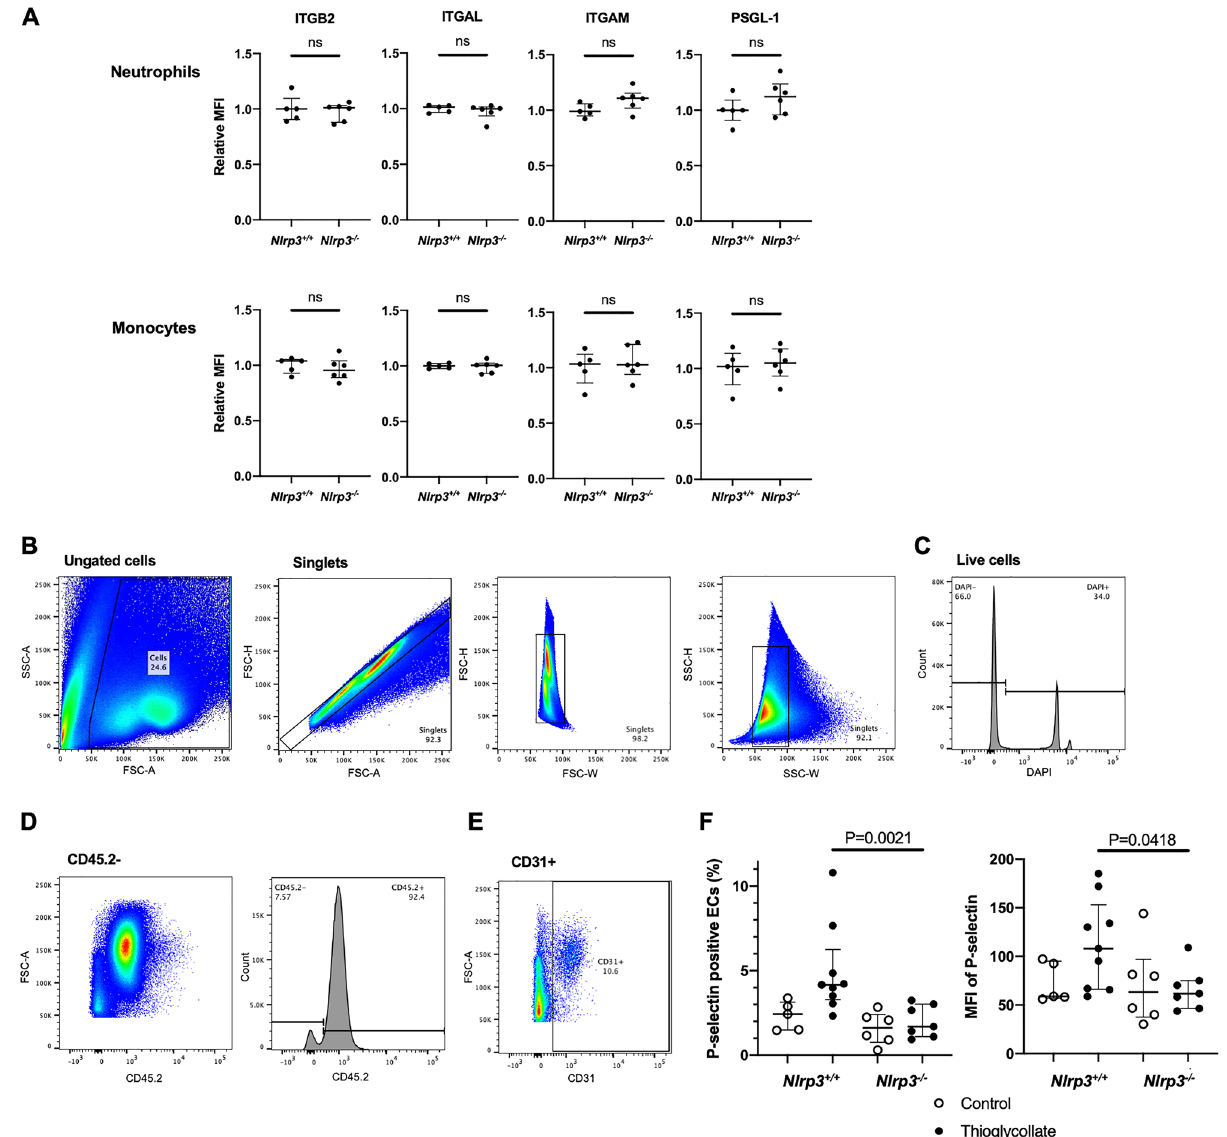
Figure 4. Nlrp3 deficiency reduces membrane expression of P-selectin on the inflamed endothelial cells, while circulating leukocyte adhesion receptors expression is not altered. Neutrophils and monocytes in peripheral blood were collected from Nlrp3 + / + and Nlrp3 −/− mice 4 h after injection of thioglycollate broth (n = 5:6). ( A ) Surface expressions of integrins; integrin β2 (ITGB2, CD18), integrin αL (ITGAL, CD11a), integrin αM (ITGAM, CD11b), and P ‐ selectin glycoprotein ligand 1 (PSGL-1, CD162) were analyzed by flow cytometry. The relative MFI was calculated as a relative value to an average MFI of Nlrp3 + / + . (B-F) Endothelial cells were isolated from the mesentery of Nlrp3 + / + and Nlrp3 −/− mice 4 h after injection with thioglycollate (Thioglycollate, closed circles, n = 9:7) or PBS (Control, open circles, n = 5:6). Surface P-selectin expression was analyzed by flow cytometry. ( B – E ) Gating strategy for isolated endothelial cells. Endothelial cells were defined as negative for CD45.2 and positive for CD31; ( B ) ungated cells and singlets, ( C ) live cells as negative for DAPI, ( D ) CD45.2 negative and ( E ) CD31 positive. ( F ) P-selectin expression on gated endothelial cells. Left: percentage of P-selectin positive endothelial cells. Right: mean fluorescent intensity (MFI) of